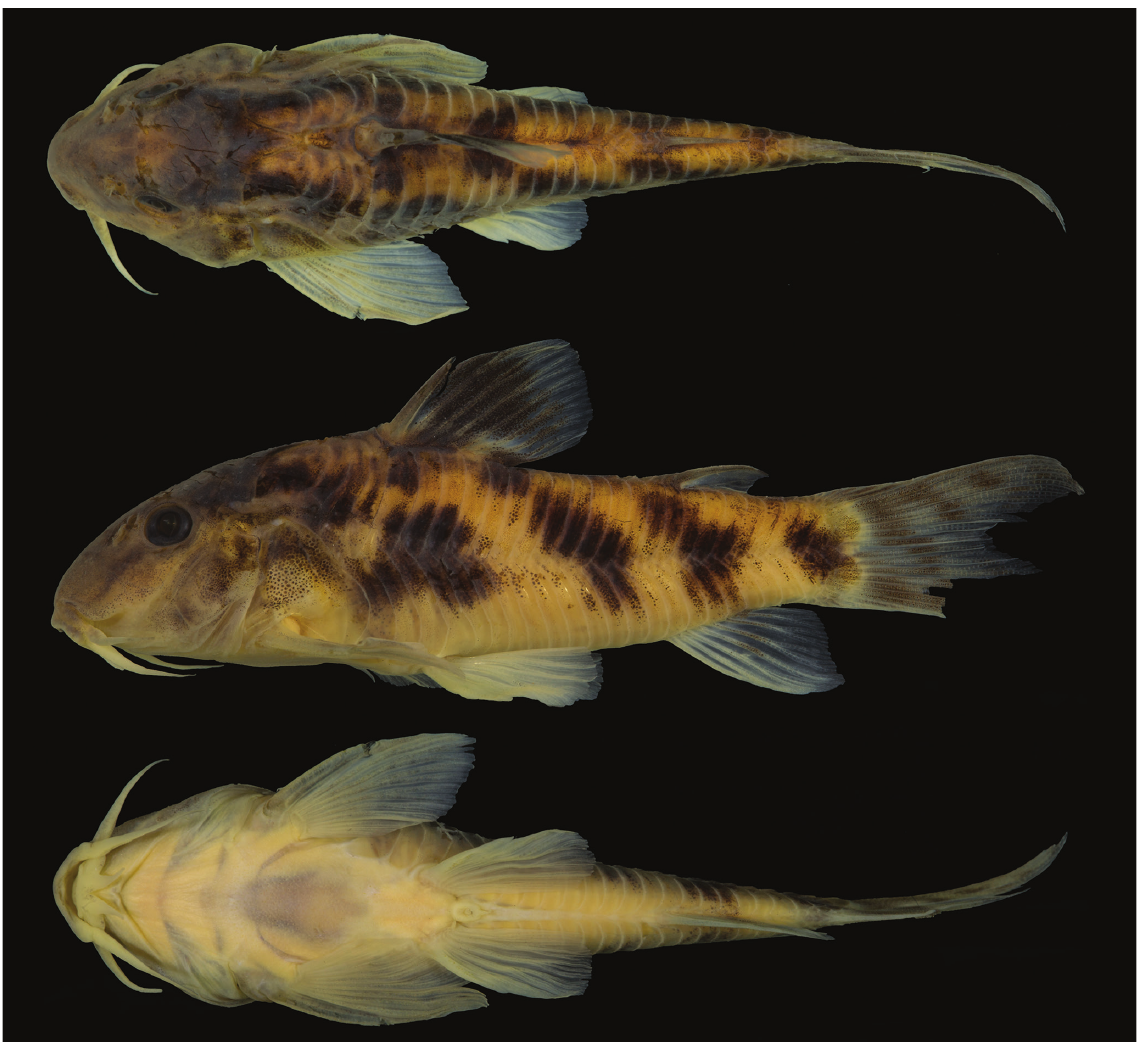
Fig. 1. Aspidoras kiriri , holotype, MNRJ 47400, 30.6 mm SL, Brazil, Bahia, Serra da Jibóia, Varzedo, rio da Dona basin, riacho Cai-Camarão. Dorsal, lateral and ventral